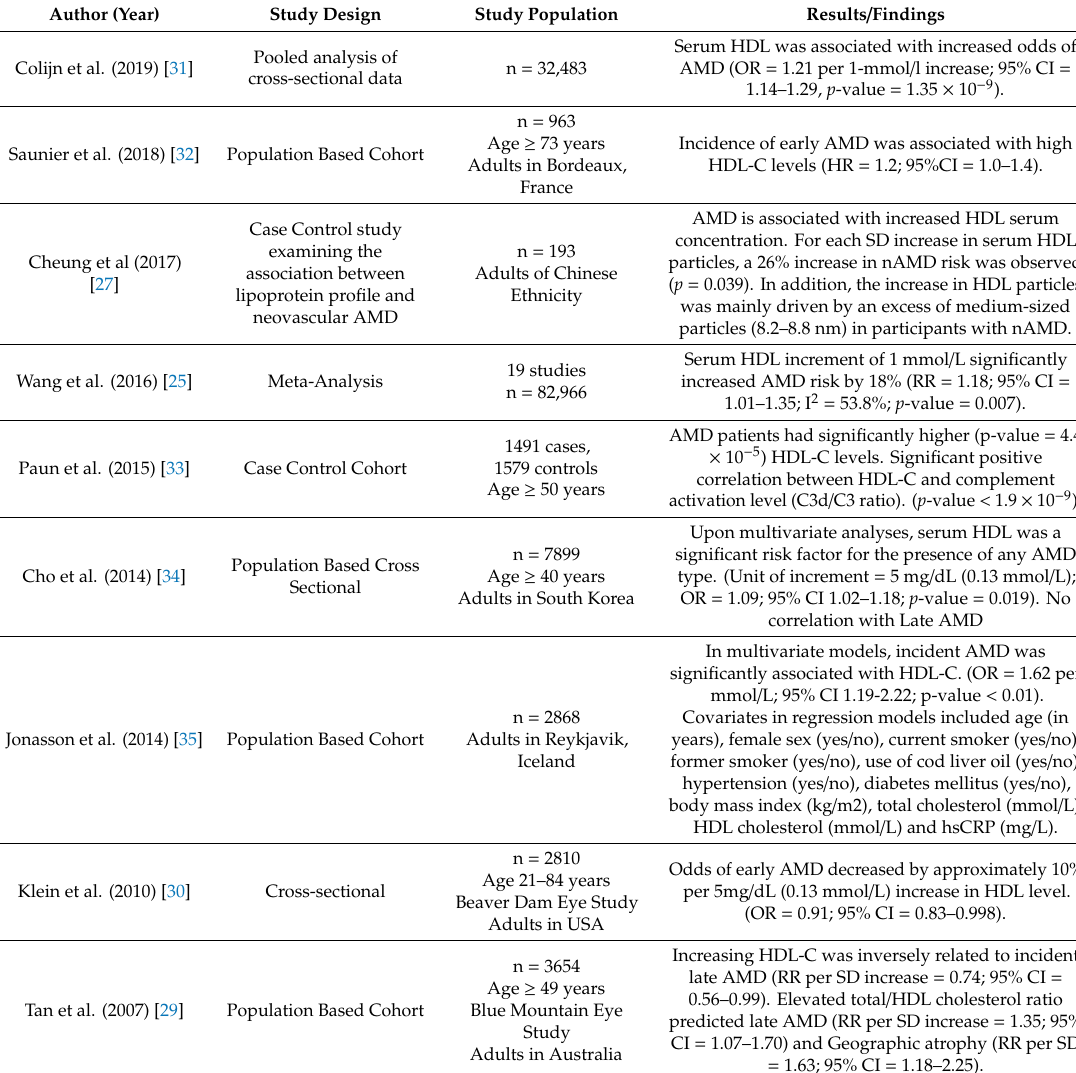
Table 1. HDL-C and AMD—Epidemiological Links from Observational Studies